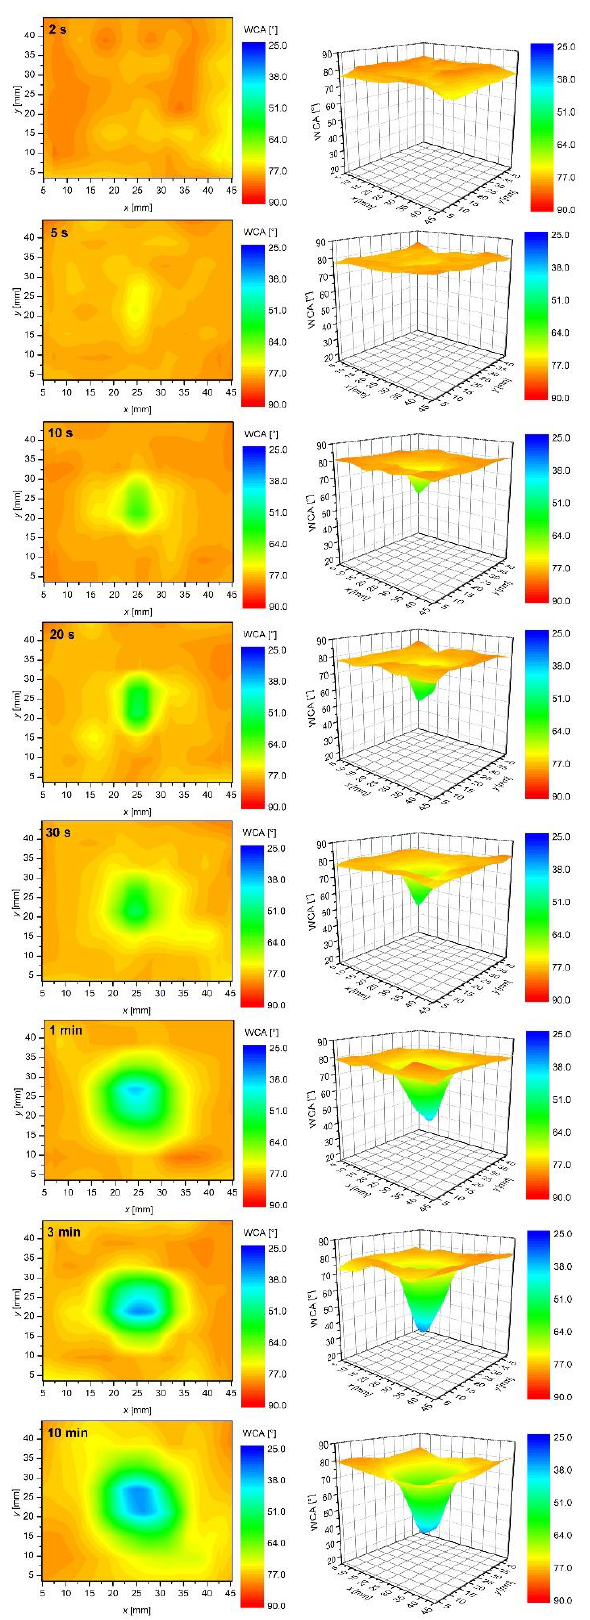
Figure 9. The time evolution of water contact angles on samples placed 30 mm below the APPJ nozzle.